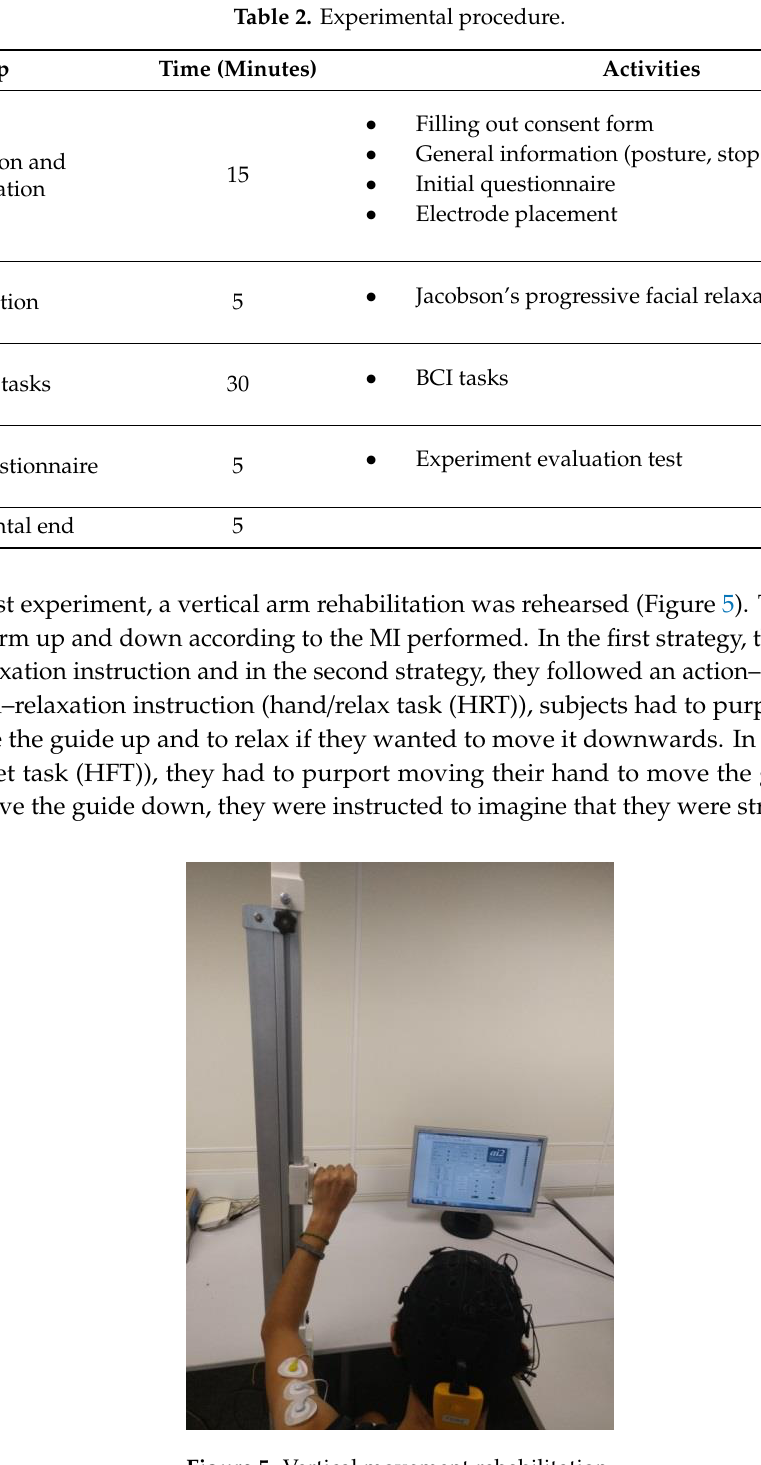
Figure 5. Vertical movement rehabilitation.